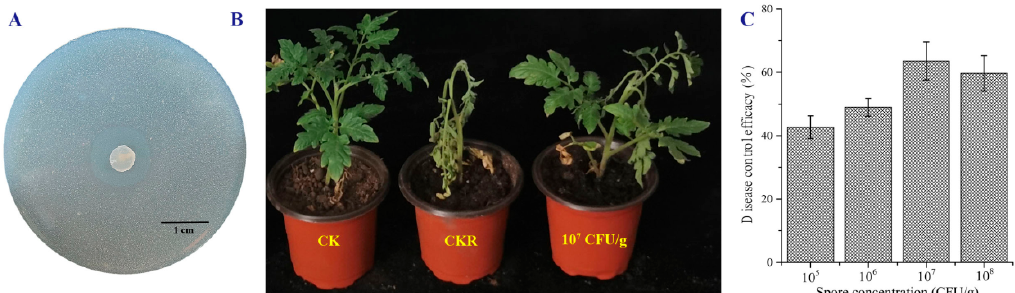
Figure 4. Antibacterial activity of strain LD120 T against R. solanacearum . ( A ) the antagonistic activity against R. solanacearum in the sucrose-peptone agar (SPA) plate. ( B , C ) biocontrol assay of inoculation with R. solanacearum and strain LD120 T on tomato seedlings in the greenhouse.